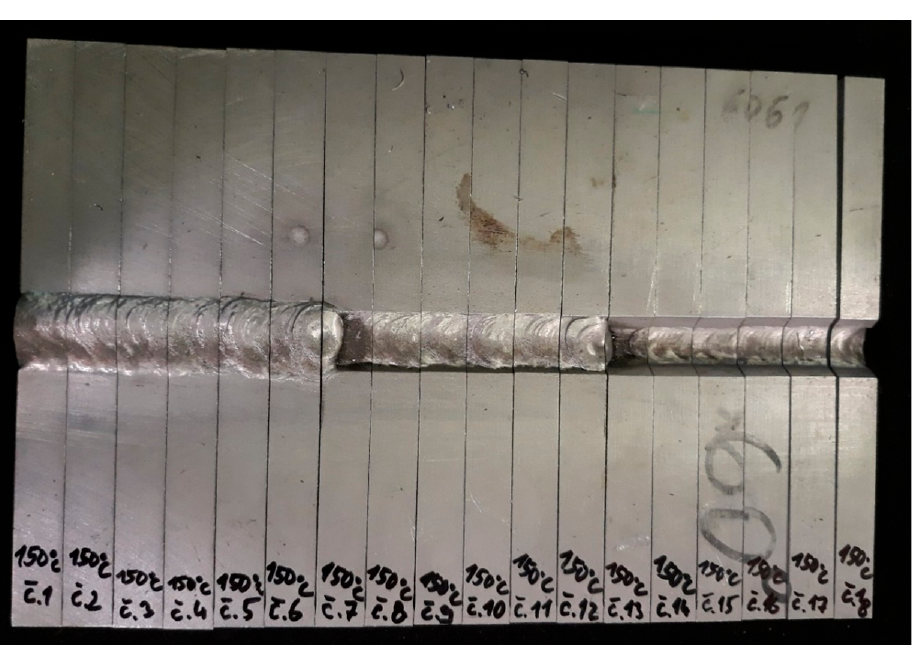
Figure 5. Plate made from alloy AW 6061, welded and cut to assess the specimen’s influence intensity.